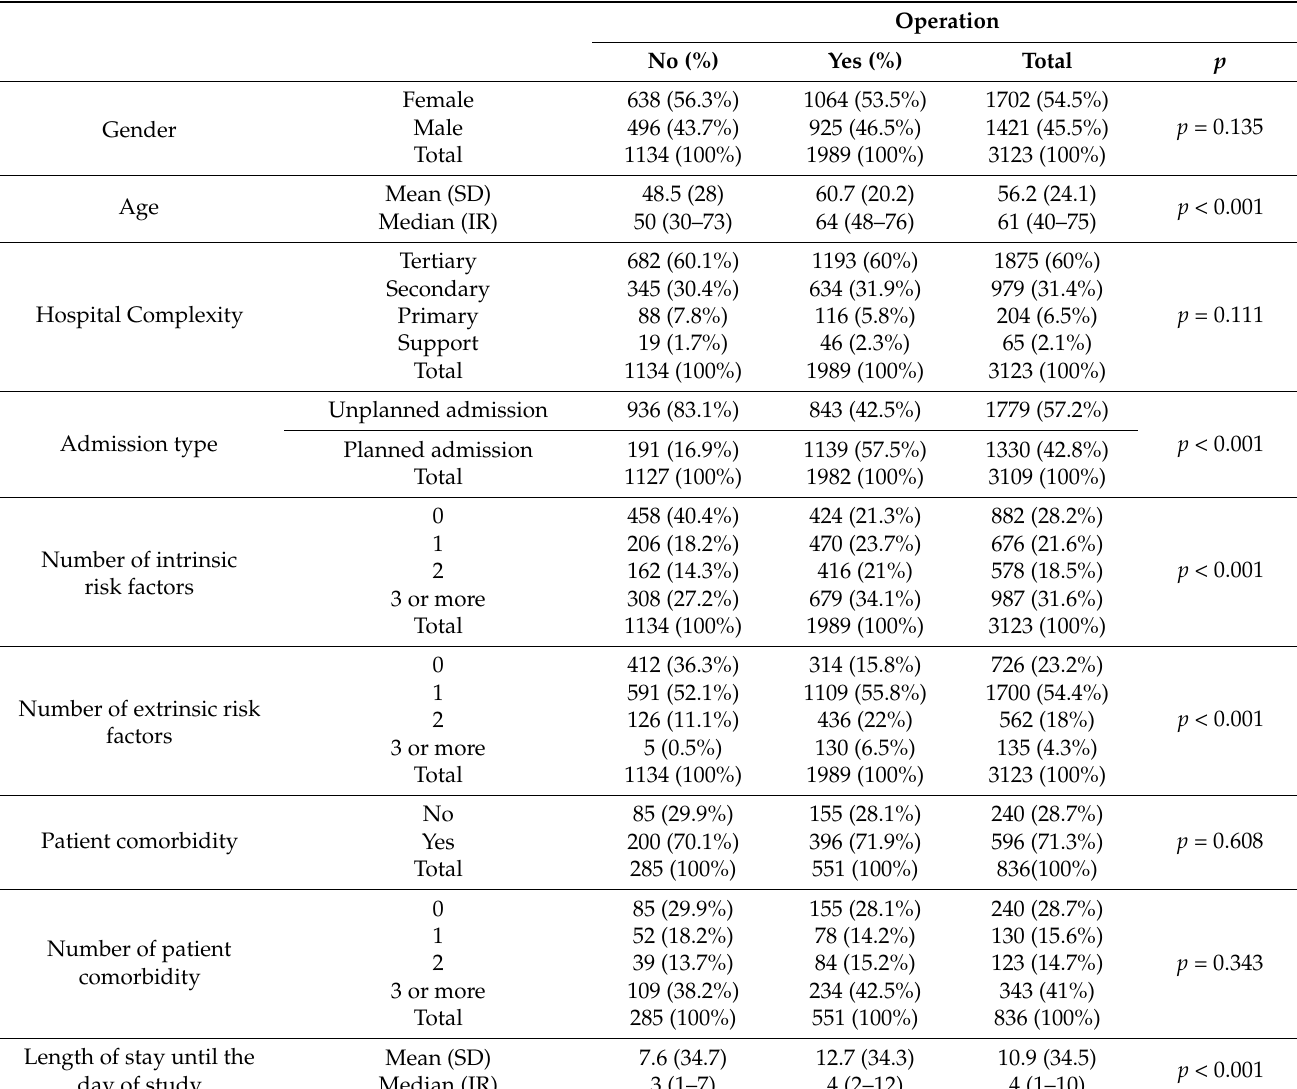
Table 2. Characteristics of the study population in operated and non-operated